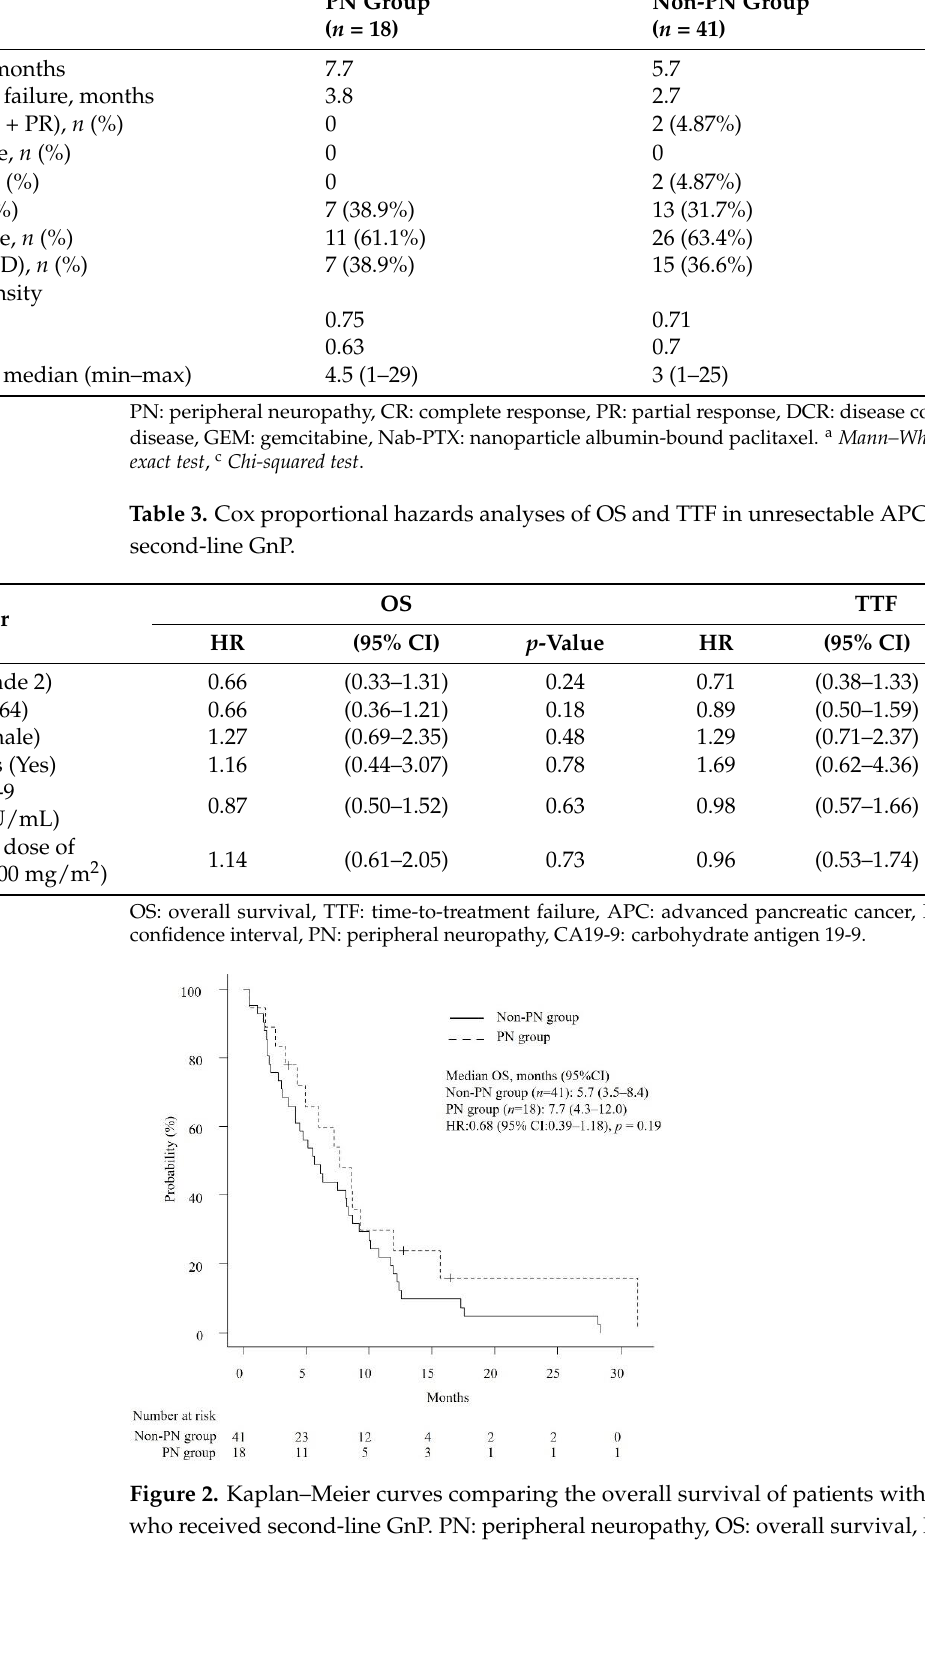
Figure 3. Kaplan – Meier curves comparing the time-to-treatment failure of patients with unresec- table APC who received second-line GnP. PN : peripheral neuropathy, TTF : time-to-treatment fail- ure, HR : hazard ratio.